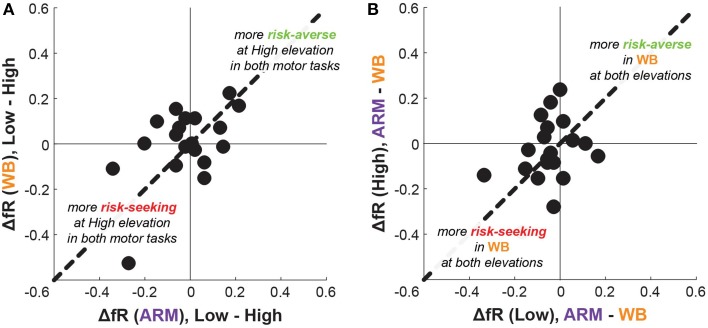
Difference in frequency of risky choices between elevations and tasks. (A) Each subject's elevation-based change in fR for the ARM task compared with the WB task. A positive ΔfR corresponds to a subject who had a higher fR at Low elevation than at High elevation, thusly becoming more risk-averse with increasing elevation. A value along the line of unity corresponds to an identical ΔfR in the WB task as in the ARM task, whereas a value above the line of unity—for example—corresponds to having a greater change in risk-sensitivity in the WB task than in the ARM task. (B) Each subject's motor-based change in fR for Low elevation compared with the High elevation. A negative ΔfR here corresponds to a subject who had a higher fR in the WB task than in the ARM task. Most points have a negative value on the x-axis, again illustrating that subjects were more risk-seeking in WB than in ARM at Low elevation.